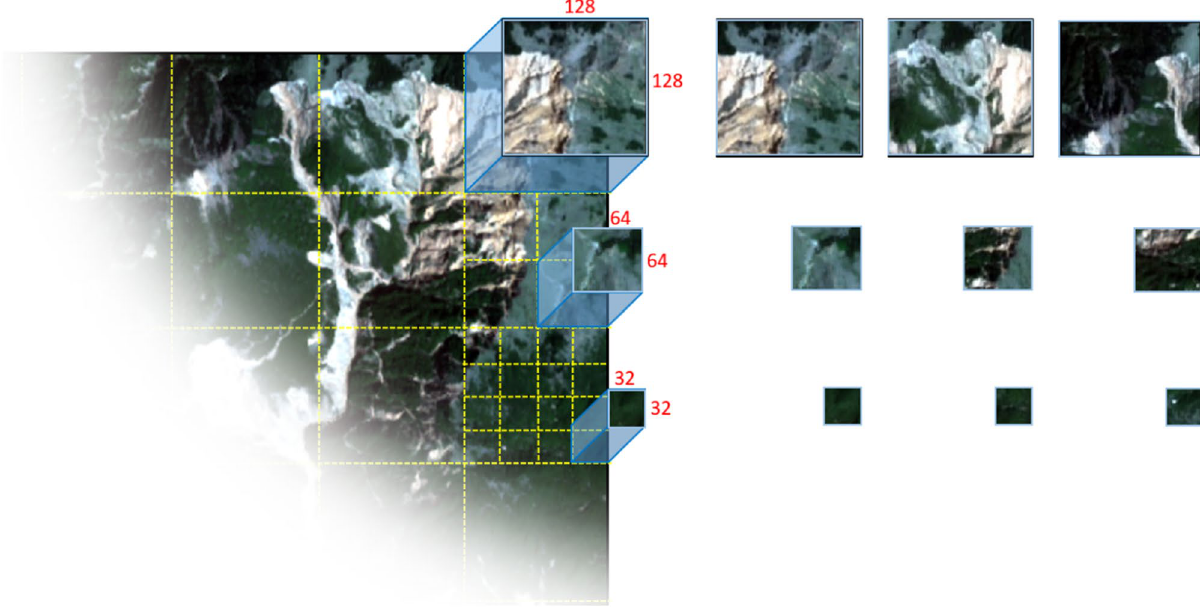
Figure 4. Systematic sample patch generation of input images by regular grid approach without any overlap. The maps were created using the ArcMap v.10.8 software (https:// deskt op. arcgis. com/ es/ arcmap/).